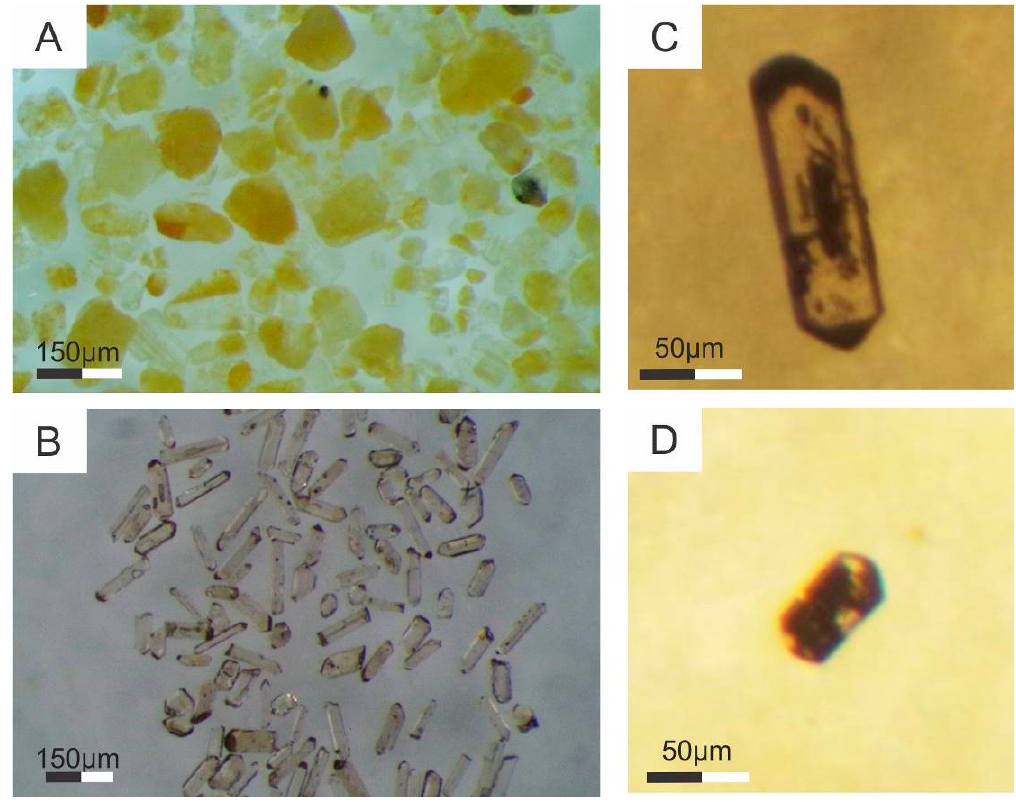
Figure 5. ( A ) and ( B ). Images of representative analysed zircons from the examined tuff samples. ( C ) Figure 5. ( A , B ). Images of representative analysed zircons from the examined tu ff samples. ( C , D ). Close and ( D ). Close up view of a long and a short prismatic zircon. up view of a long and a short prismatic